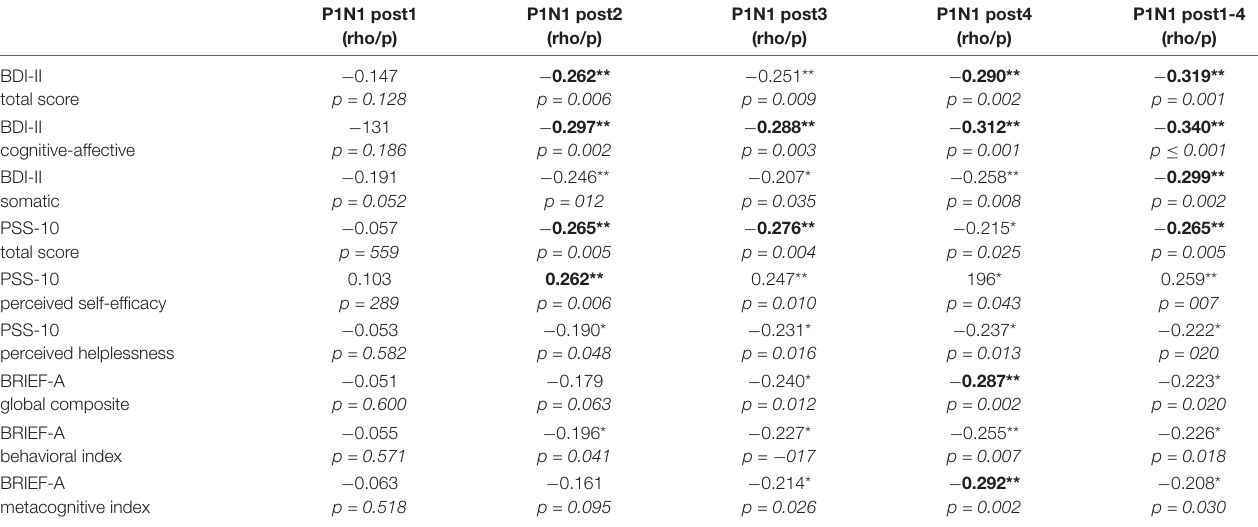
TABLE 1 | Spearman correlation analyses ( N = 109) between P1-N1 amplitude modulation of different post high frequency stimulation (HFS) time points and self-reported depressive symptoms (BDI-II), perceived stress (PSS-10), and executive function (BRIEF-A). P1N1 post1